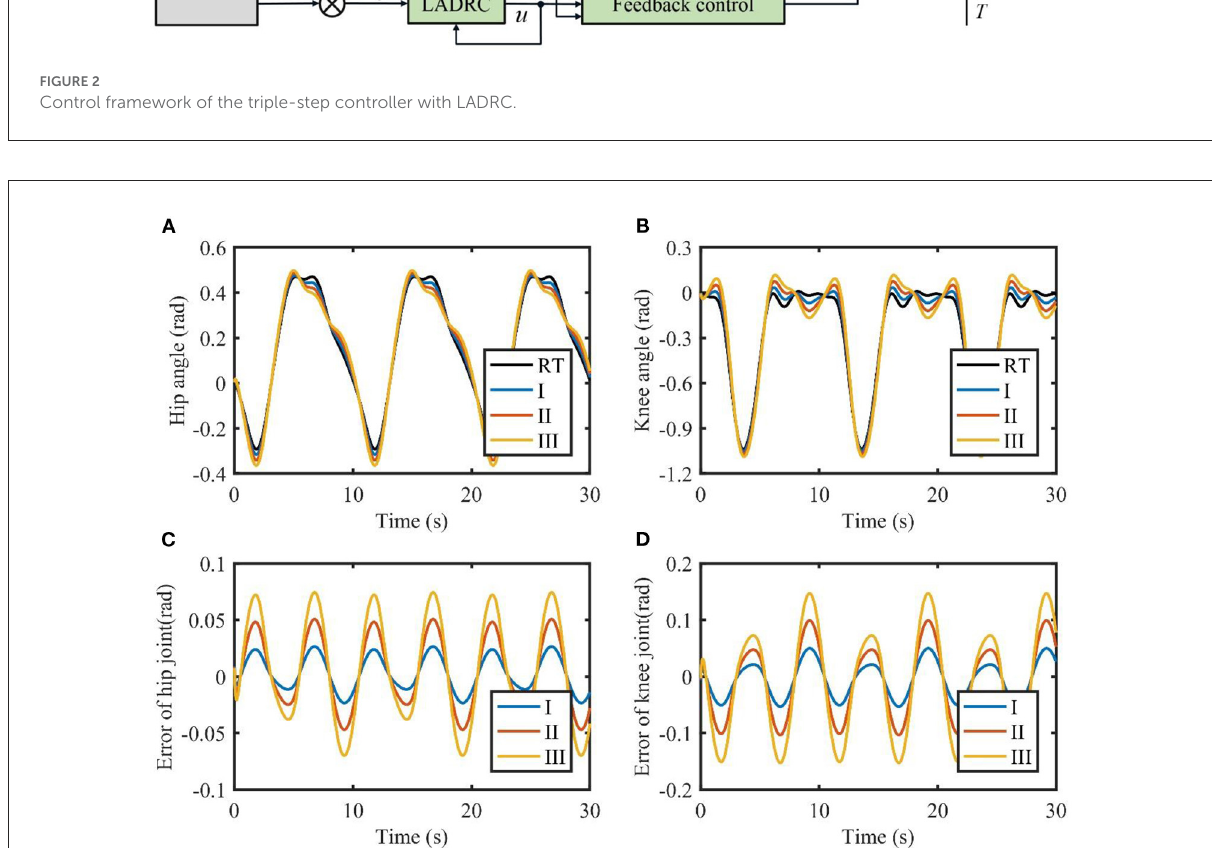
FIGURE3 Tracking performance of TSC with different loads. (A,B) are the joint angles of the hip and knee. (C,D) are the tracking errors of the hip and knee. I, II, and III represent three cases of different loads. RT, reference